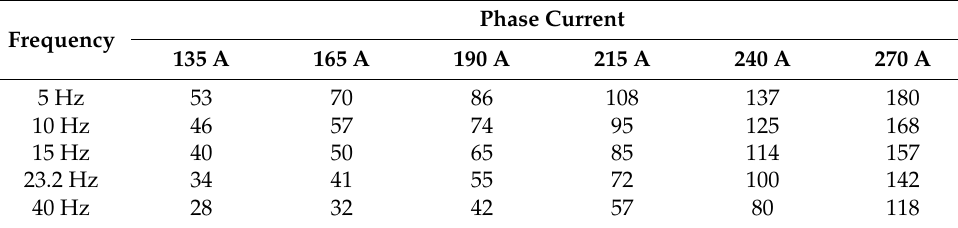
Table 7. Maximum steady-state temperatures of primary winding during forced